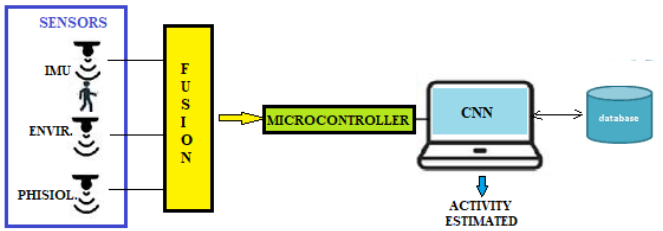
Figure 15. HAR system